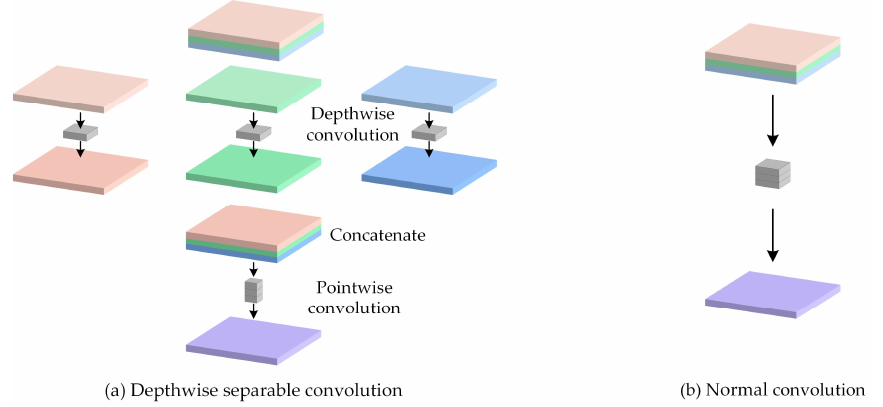
Figure 2. Schematic diagrams of the DSC and the normal convolution. The left figure ( a ) shows the DSC, while the right figure ( b ) shows the normal convolution.